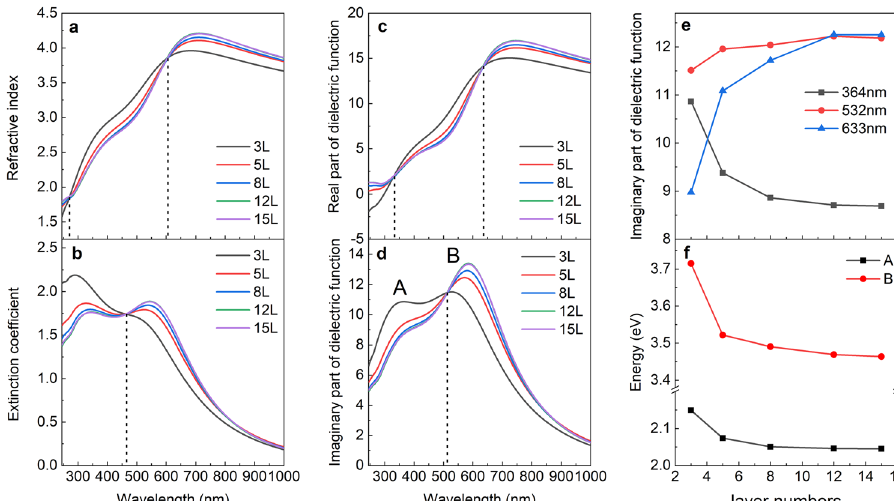
Fig. 4 Optical properties of PdSe 2 with different layer numbers. a Refractive index. b Extinction coef fi cient. c The real part of the dielectric function. d The imaginary part of the dielectric function. e Correlation between ε i and layer numbers at three commonly used laser wavelengths. f Correlation between the central energy of exciton peaks and layer